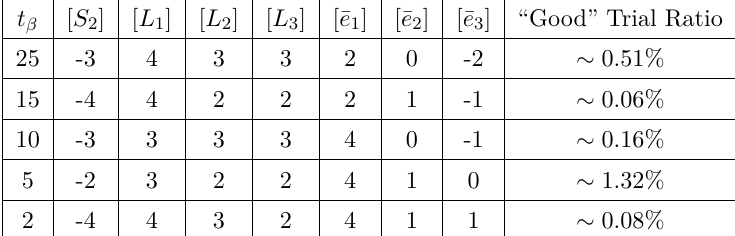
table 1. We report the bounds on the models with different values of tuning